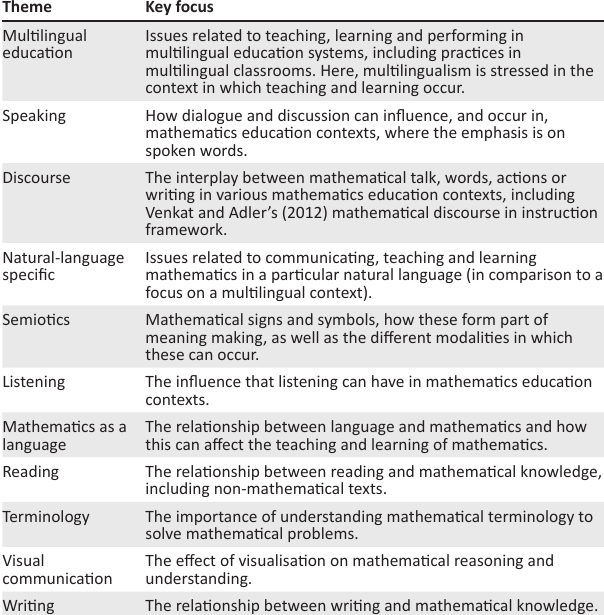
TABLE 2: Emergent themes from the surveyed research outputs.